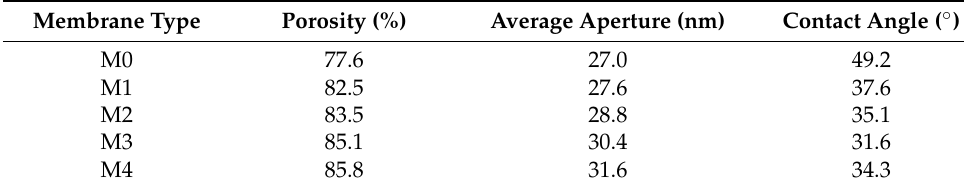
Table 2. Porosity and average pore size of